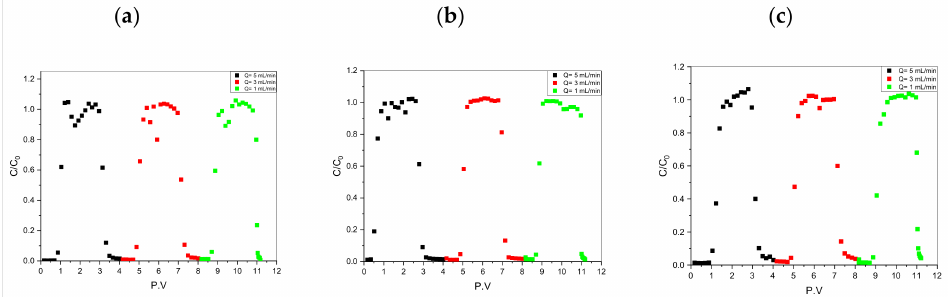
Figure 3. The ADE experimental breakthrough curves (BTCs). ( a ) HTO; ( b ) I − ; ( c ) IO 3 − .